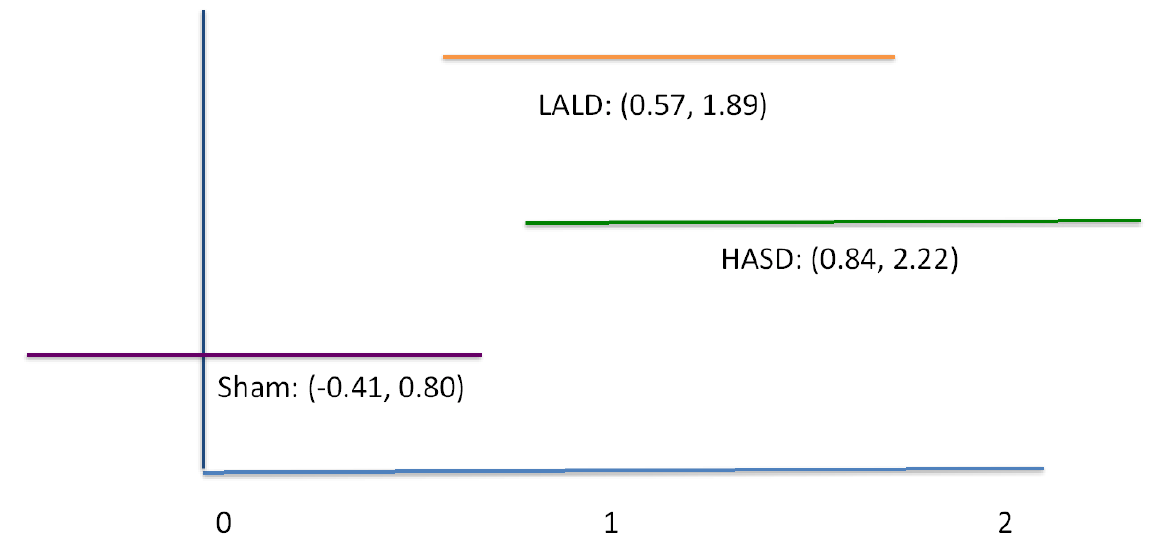
Figure 2. Confidence Intervals of each condition, indicating strong effects of both the high amplitude/short duration (HASD) and low amplitude/long duration (LALD)